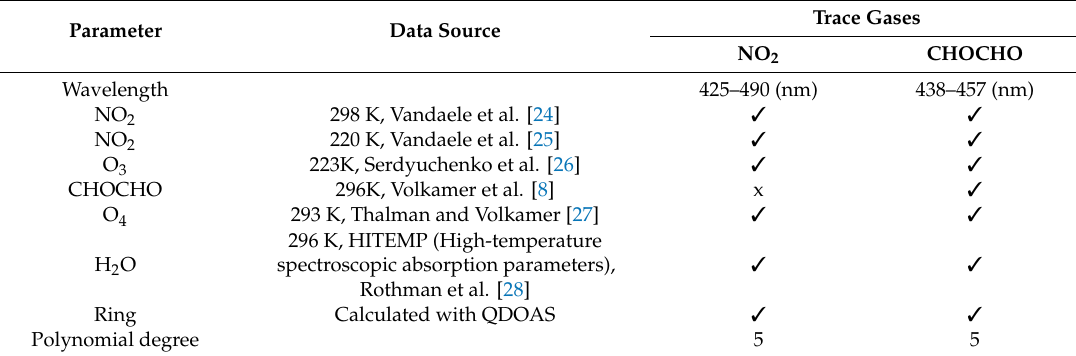
Table 1. The parameter settings used in MAX-DOAS observations.